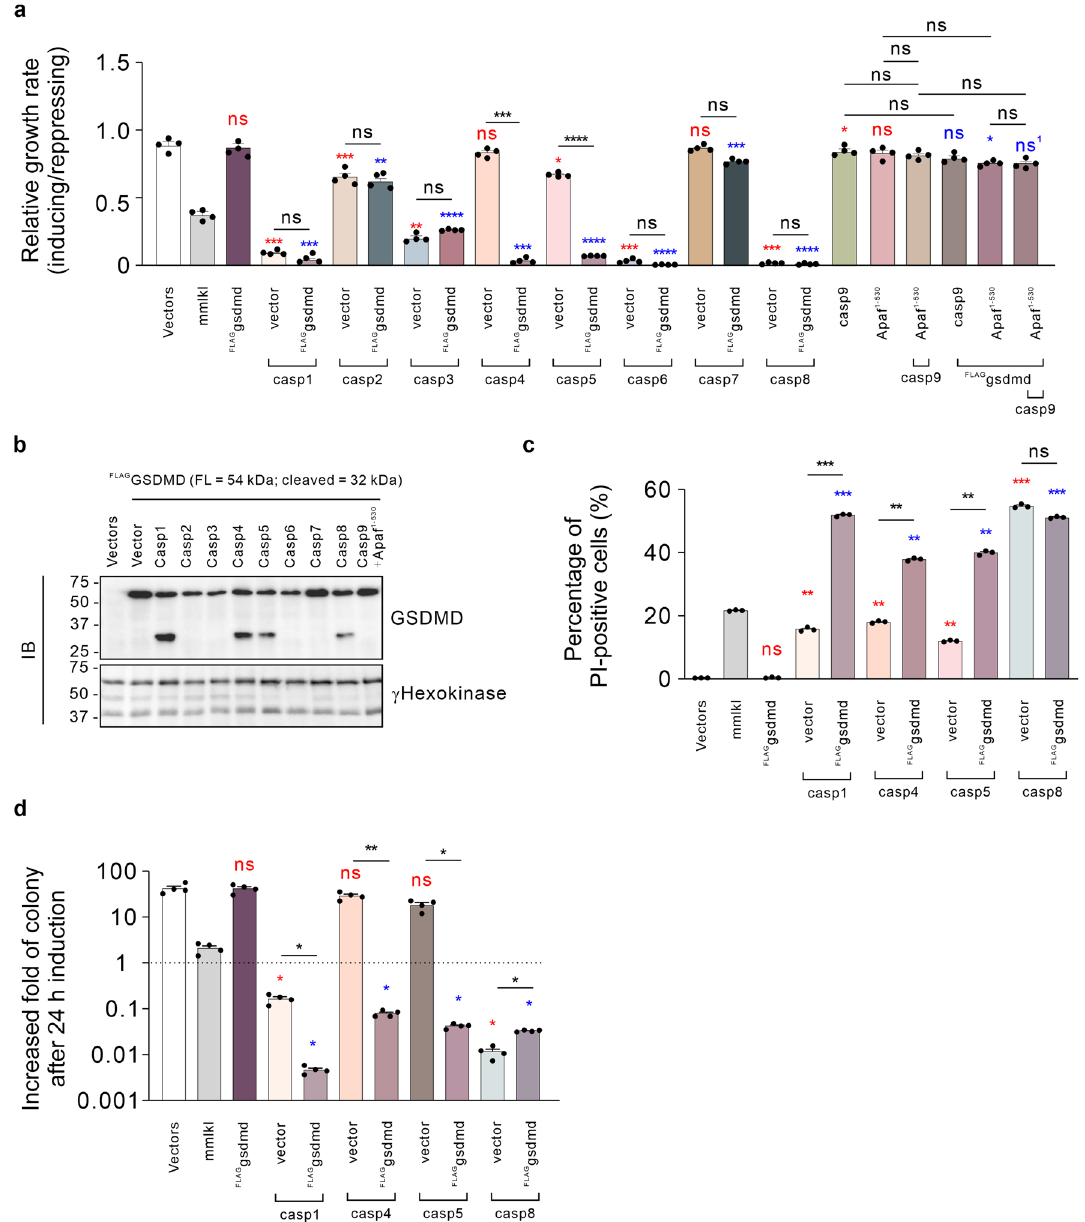
Figure 2. Reconstitution of GSDMD-mediated pyroptotic cell death in S. cerevisiae . (a) Maximal growth rates of yeast bearing expression plasmids encoding FLAG GSDMD and active caspases-1 to -9, or bearing empty vectors lacking cell death genes (labeled “Vectors”), were analyzed by monitoring rate of changes in absorbance of yeast cultured in inducing and repressing liquid media. ( b) Expression of recombinant expressed FLAG GSDMD were assessed by western blot. Loading control: anti-γhexokinase. Uncropped blots are presented in Supplementary Fig. 3. ( c) Yeast bearing expression plasmids encoding FLAG GSDMD and active caspase-1, -4, -5, or -8 were grown under inducing conditions for 24 h then clonogenicity and membrane integrity were assessed. Following galactose removal, plasma membrane integrity of each yeast culture was assessed by propidium iodide (PI) uptake. ( d) The colony-forming abilities of post-induction cultures were expressed relative to the corresponding uninduced cultures. Cells were grown in inducing media for 24 h. Following galactose removal, the post-induction cultures were diluted and plated on solid repressing media and incubated for 3 days. Data present mean ± SEM of three c or four independent assays ( a,d ). Differences in maximal growth rates ( a), PI-positive population ( c) or fold-increases in colonies ( d) of yeast expressing empty vectors versus those expressing each transgene or sets of 2 transgenes versus individual transgenes or pairs of transgenes were compared using ANOVAs with Sidak corrections. Comparisons made between yeast expressing each transgene(s) and empty vector yeast are labeled in red; Comparisons made between each transgene(s) to yeast expressing FLAG GSDMD are labeled in blue, except for ns 1 in panel ( a) , in which the comparator was yeast co-expressing FLAG GSDMD and caspase-9. Other comparisons are indicated using black lines. *, P < 0.05; **, P < 0.01; ***, P < 0.001; ns, not